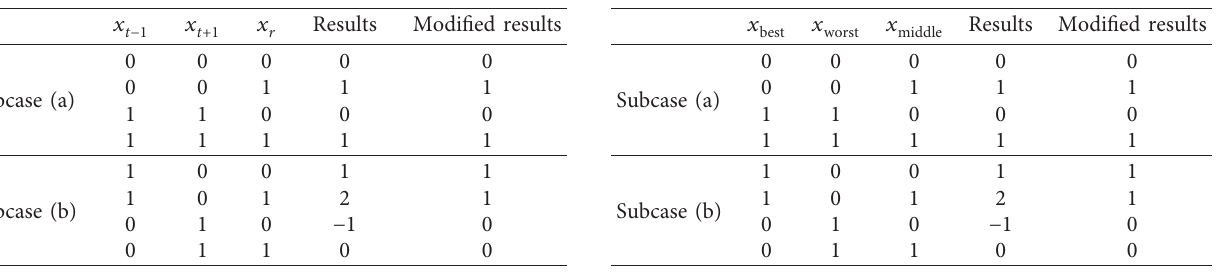
Table 6: Results of the binary junior gaining and sharing stage of Case 1 with k f � 1.